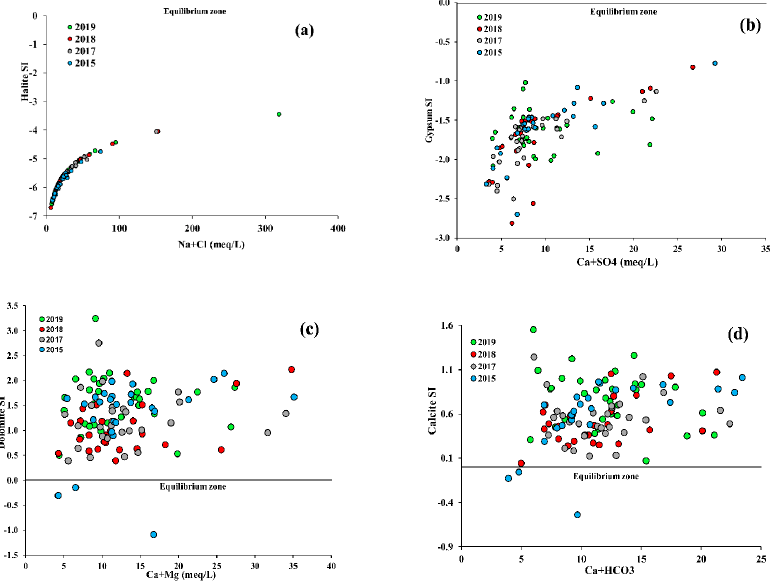
Figure 6. Relationships between: ( a ) (Na + Cl) and Halite SI, ( b ) (Ca + SO4) and Gypsum SI, ( c ) (Ca + Mg) and Dolomite SI, ( d ) (Ca + HCO3) and Calcite SI. (SI = Saturation indices). Table 2. Groundwater classification based on TDS values [44]. (TDS = Total Dissolved Solids). TDS (mg/L)